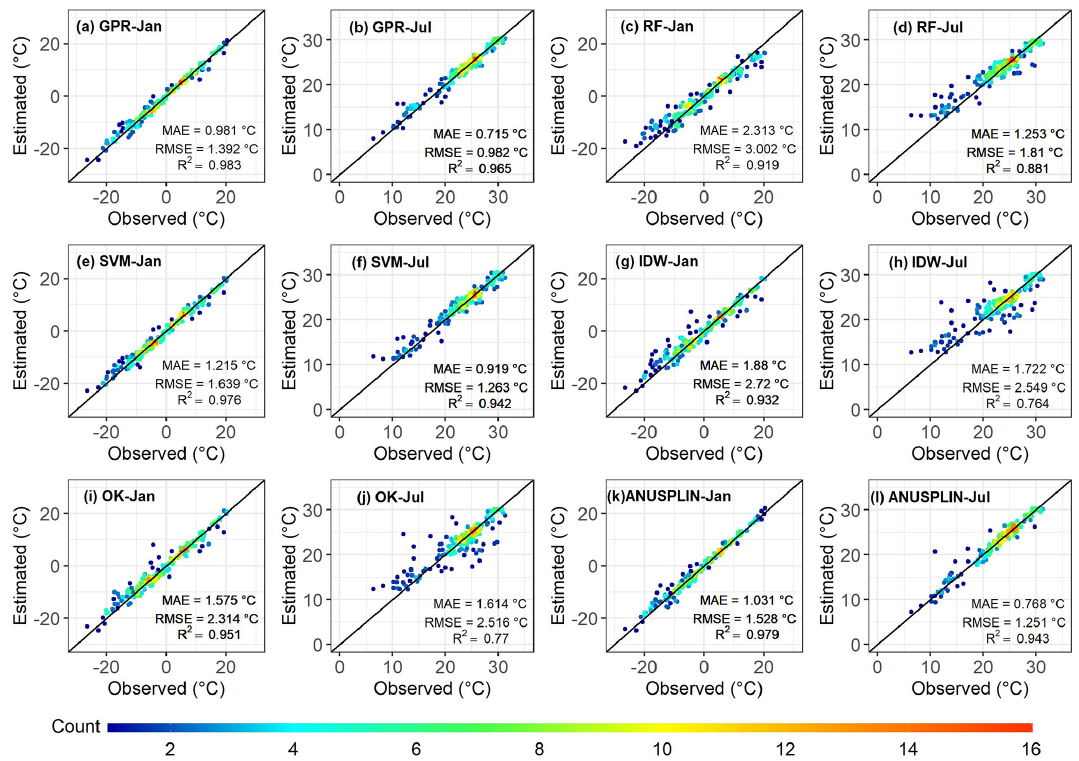
Figure 9. Scatter plots of Tmean estimated by the machine learning models and traditional models against observed monthly mean temper- ature in January and July